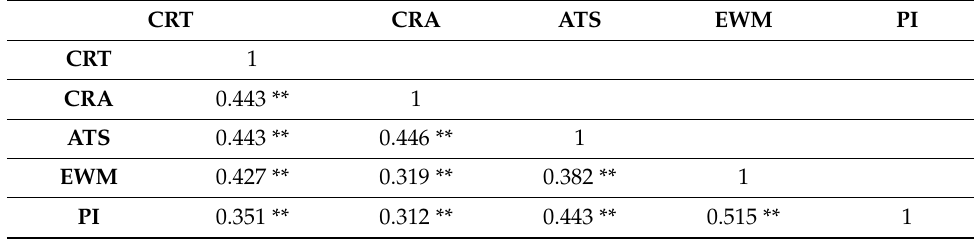
Table 5. Bivariate correlations.